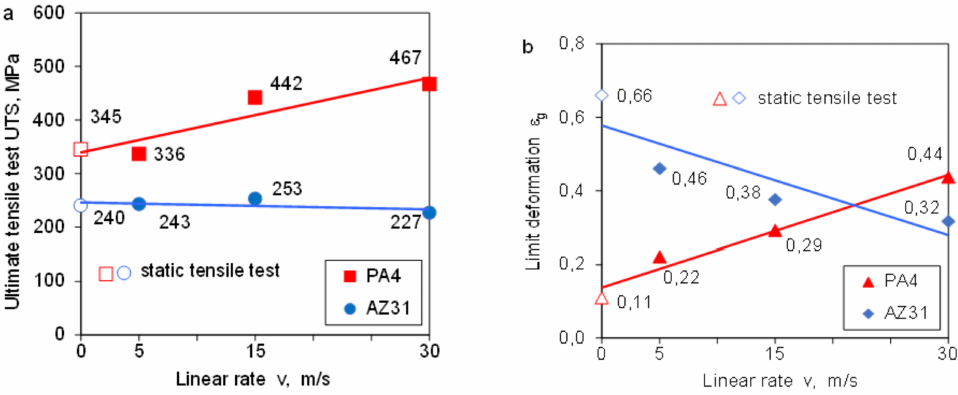
Figure 9. Tensile strength ( a ) and limit of deformation ( b ) as a function of the linear rate of the impact hammer for PA4 and AZ31.